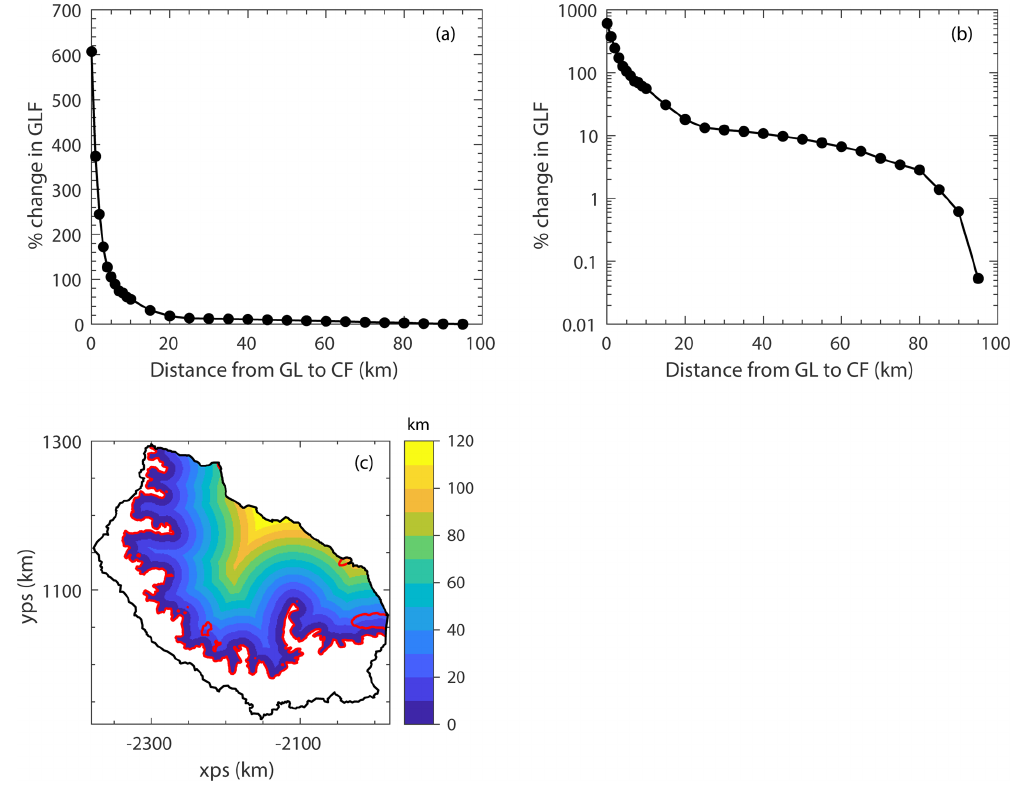
Figure 4. Calving experiments: (a) is the percentage change in grounding line flux for the each idealised calving experiment, and (b) shows the same data, but with a log scale on the y axis. A map of the “distance to the main grounding line” metric, used to define the calving experiments, is shown in (c) , where the red line is the grounding line and the black line the boundary of the model